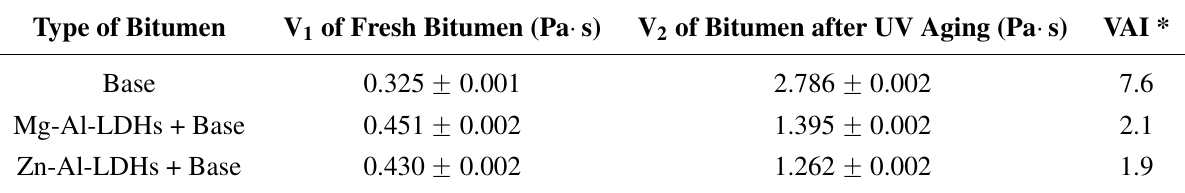
Table 1. Dynamic viscosity of base and modified bitumens before and after UV aging at 135 ˝